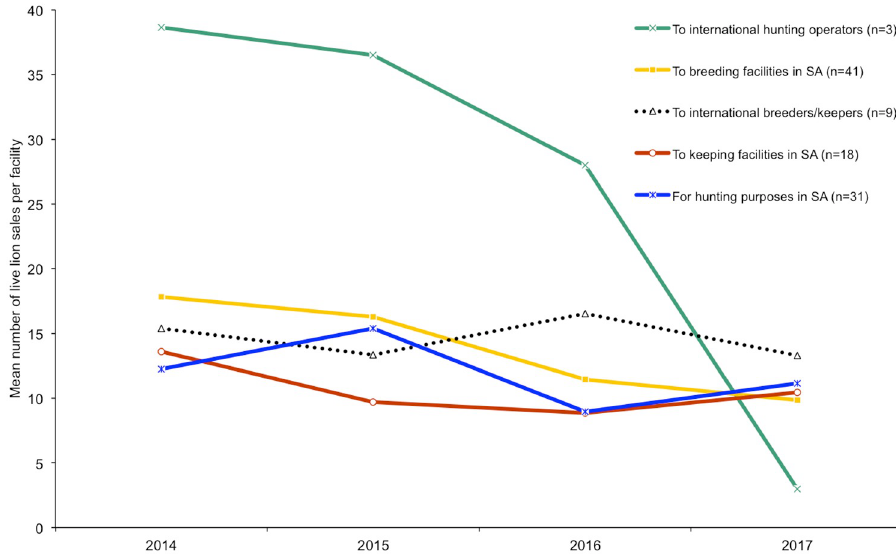
Fig 4. Mean number of live lion sales per responding facility from 2014 to 2017. Note : international hunting operators are not based in South Africa and the lions are hunted in the country they are exported to. Results correspond to Question